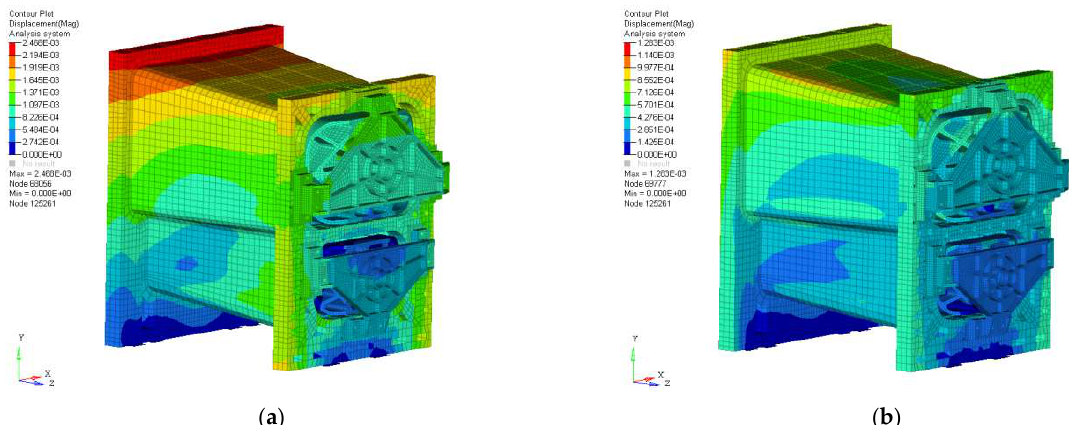
Figure 9. Comparison and analysis of thermal deformation of support structure; ( a ) support structure with isotropic layers; ( b ) support Structure with zero-expansion layer. Table 4. Reflector position deviation with a temperature rise of 5 °C.